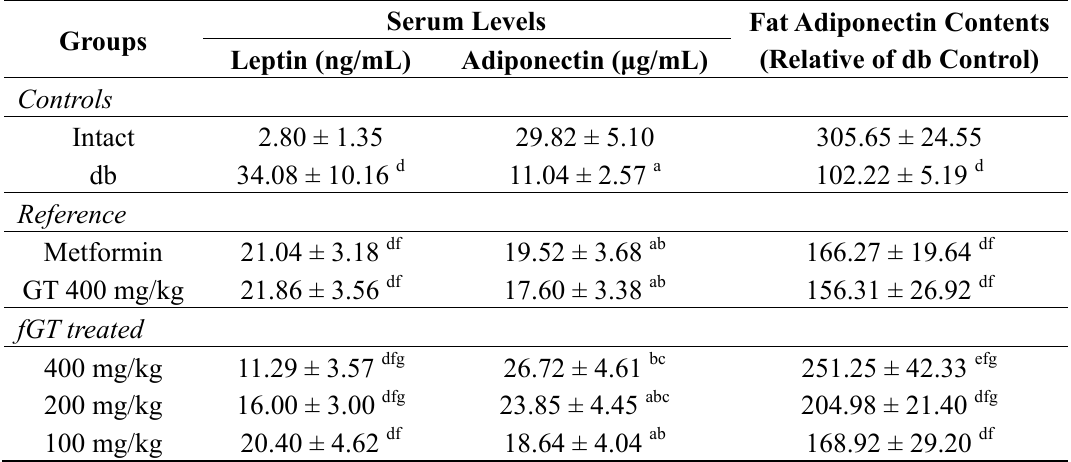
Table 5. Serum leptin and adiponectin levels with periovarian fat adiponectin contents in intact normoglycemic and db/db mice.